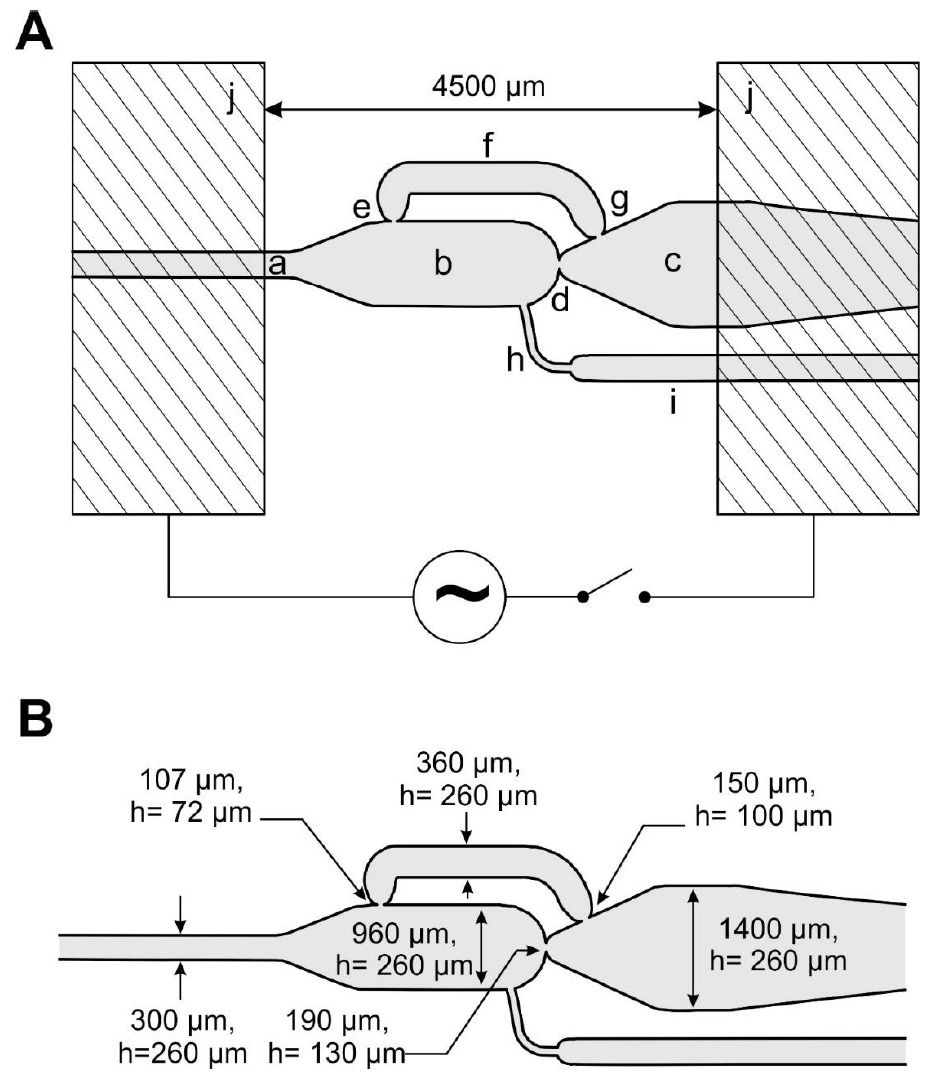
Figure 1. ( A ) Layout of the droplet generation and coalescence device ( a ) ~40 nL droplet delivery channel, ( b ) main chamber/coalescence chamber, ( c ) drain channel for > 500 nL droplets, ( d ) main channel nozzle, ( e ) bypass inlet nozzle, ( f ) bypass channel ( g ) bypass outlet nozzle, ( h ) feeding-channel for diluting liquids (dispersed-phase), ( i ) supply channel, ( j ) metallic electrode on top of the device. ( B ) Geometric dimensions of the droplet generation and coalescence unit (channel width, h = height).